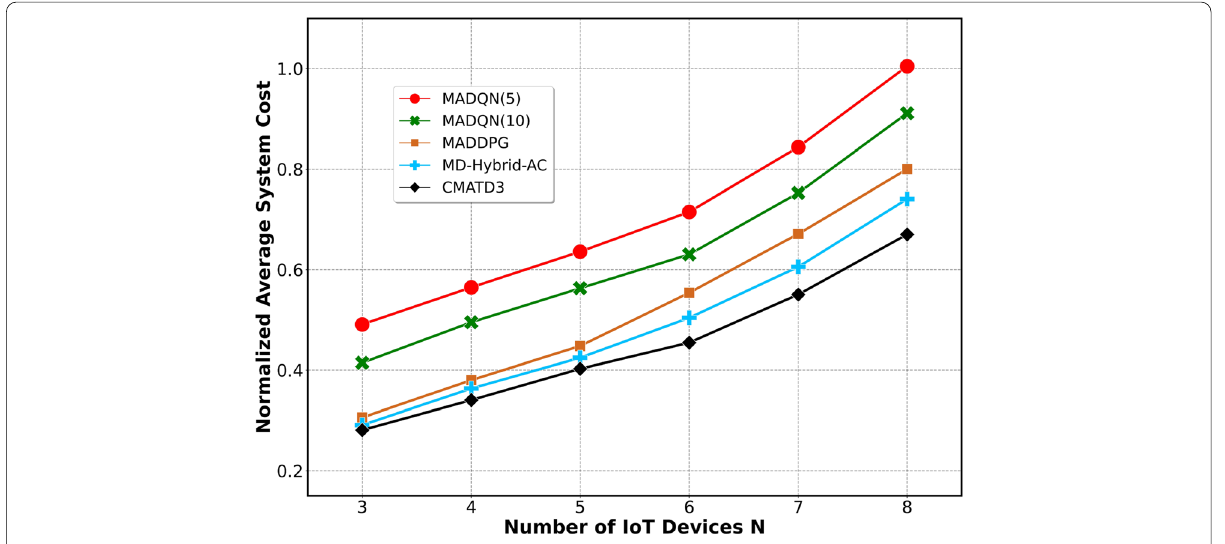
Fig. 10 Results of normalized average system cost vs. N